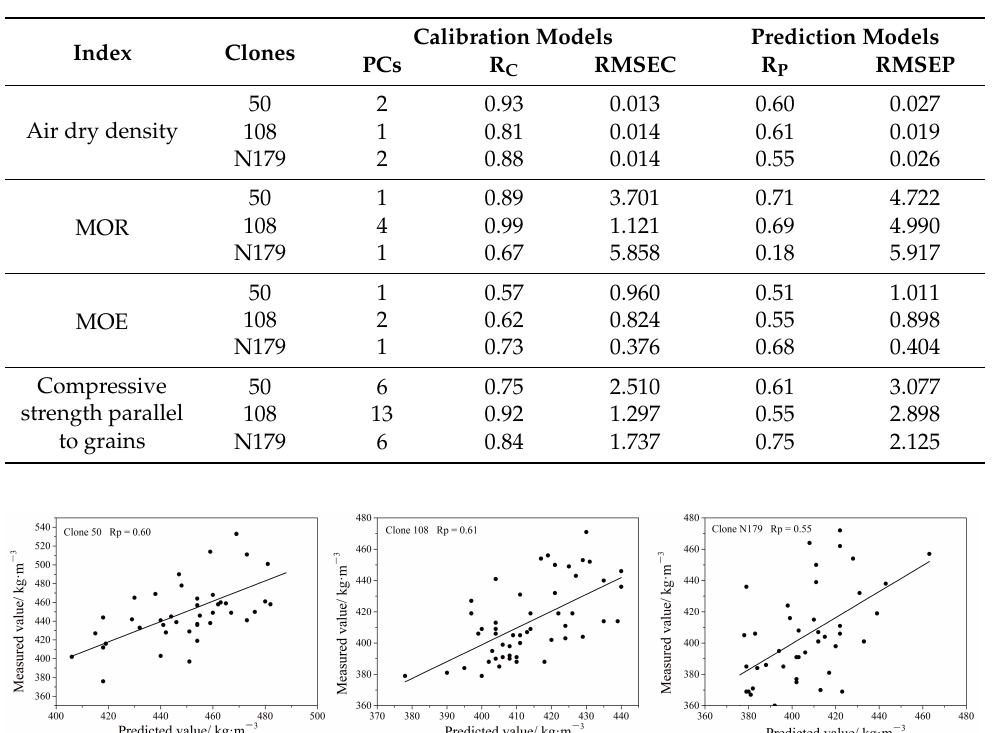
Table 8. PLS calibration and prediction model statistical table for four properties of three clones.